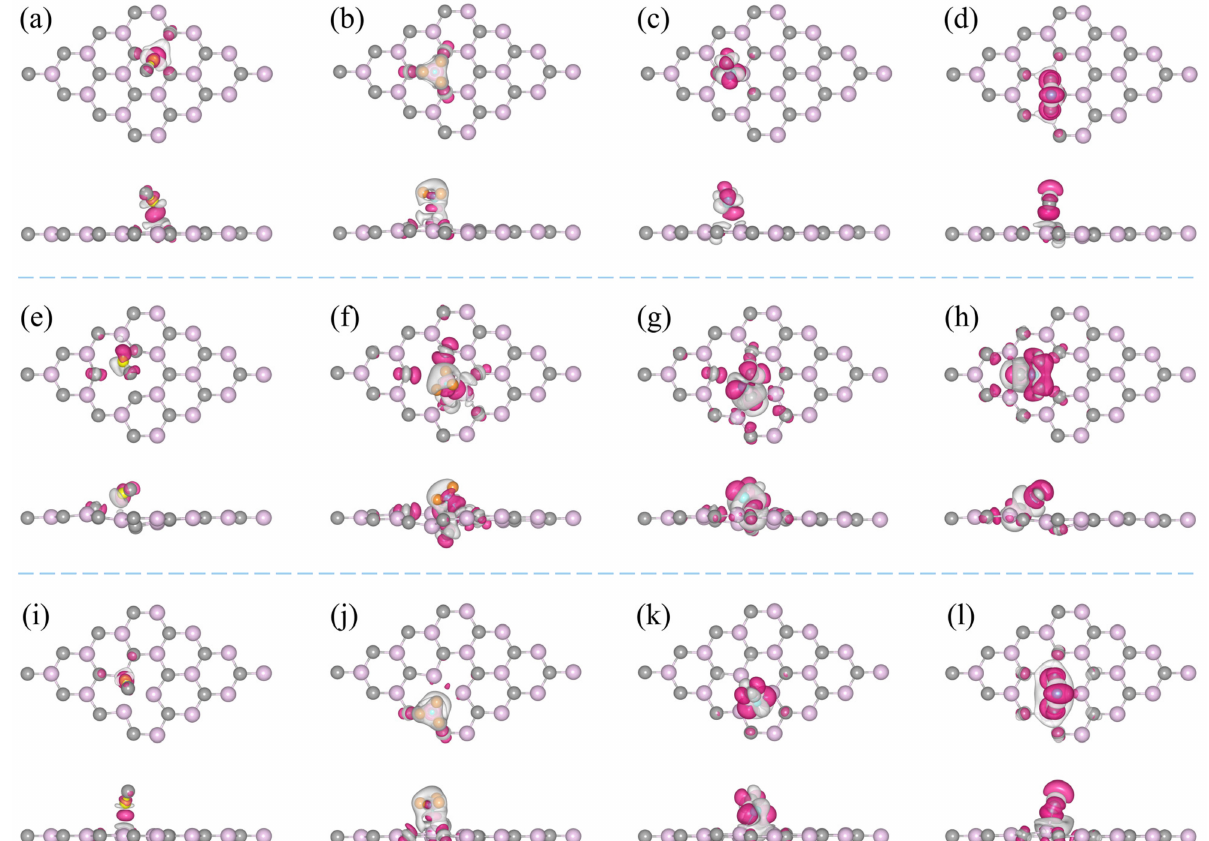
Figure 5. The isosurface of the CDD with a value of 0.001 e Å − 3 for the ( a ) CO, ( b ) NH 3 , ( c ) NO, or ( d ) NO 2 adsorbed on intrinsic g − ZnO systems, ( e – h ) for the V Zn /g − ZnO adsorption systems, and ( i – l ) for the V O /g − ZnO adsorption systems. The white area and peachy red area represent the depletion and accumulation of electrons, respectively. The pink, grey, yellow, orange, and blue balls are the Zn, O, C, H, and N atoms,